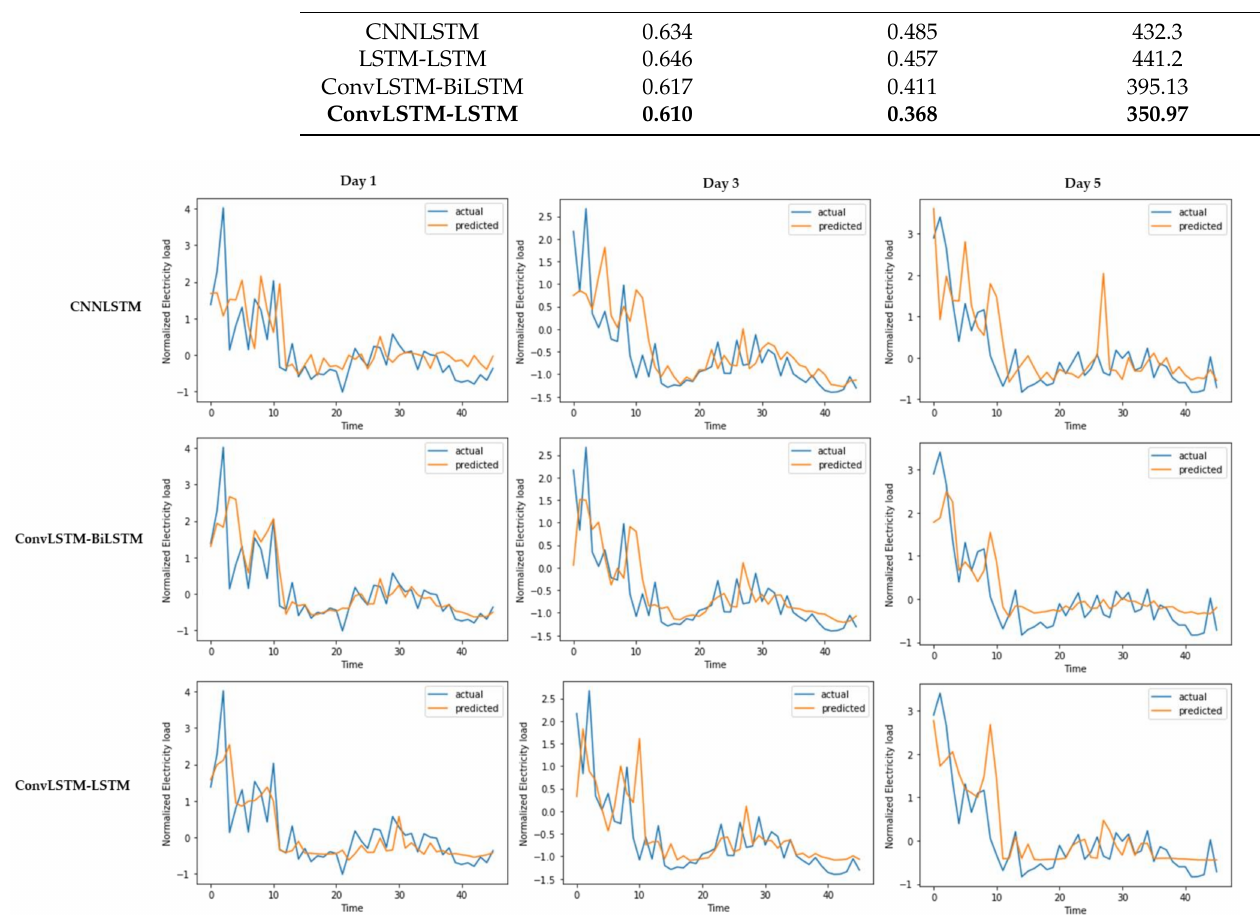
Figure 14. Daily total actual consumption vs. prediction results over a test samples for different days in a week with NYISO